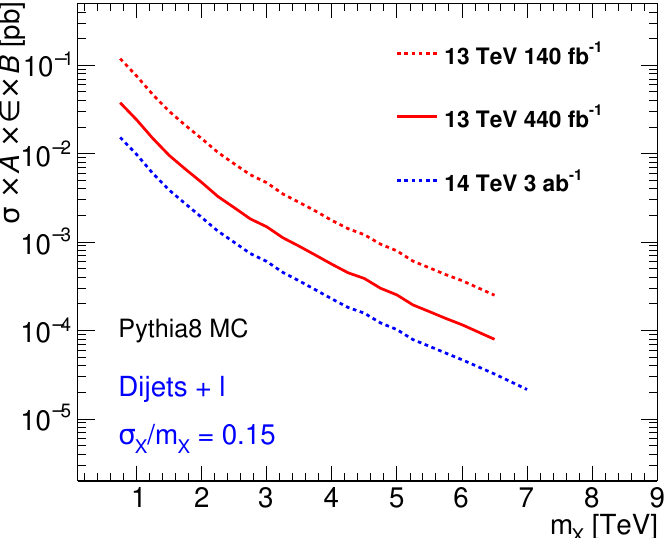
Figure 10. The 95% C.L. upper limits obtained from the m jjl distribution on cross-section times accep- tance ( A ), efficiency ( (cid:101) ) and branching ratio (BR), for a BSM signal with a cross-section that produces a Gaussian contribution to the particle-level m jjl distribution, as a function of the mean of the Gaussian mass distribution. The limits are calculated for a BSM signal assuming σ X / m X = 0.15